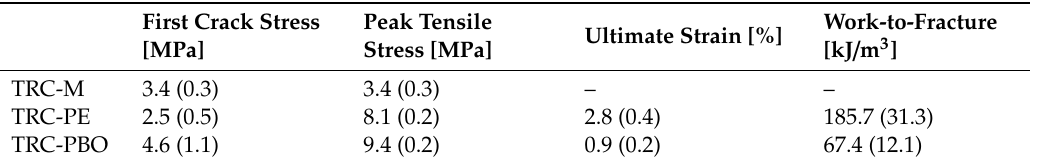
Table 4. Results of the uniaxial quasi-static tests on the investigated composites (average values; standard deviations are given in